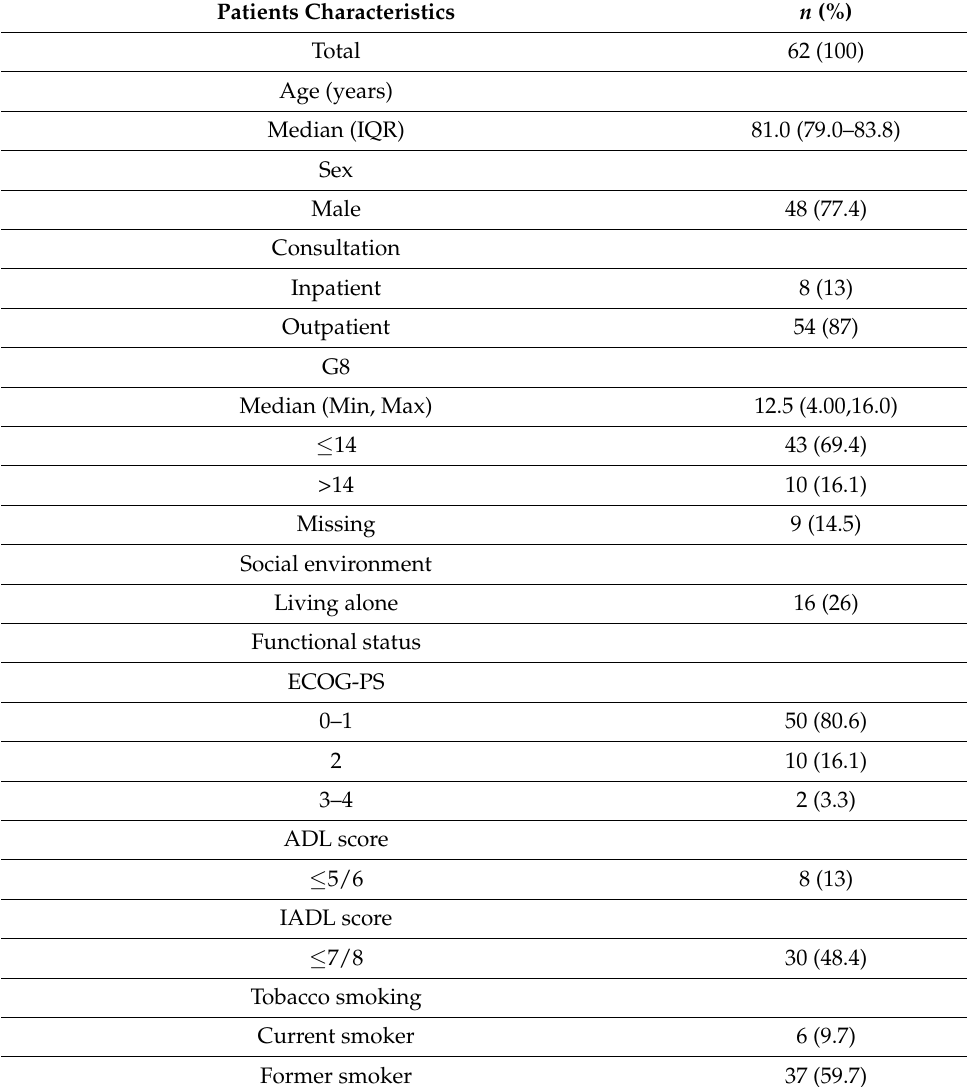
Table 1. Characteristics of the study